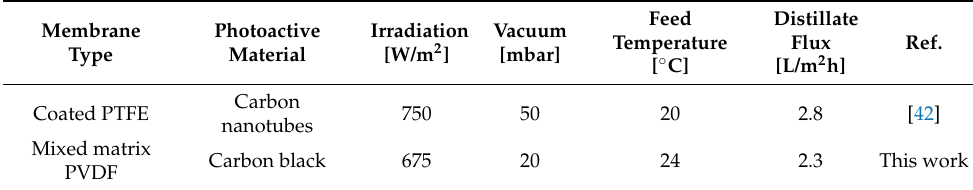
Table 4. VMD performance